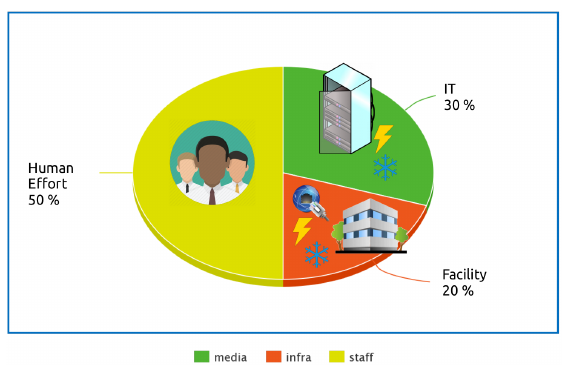
Figure 4. Holistic